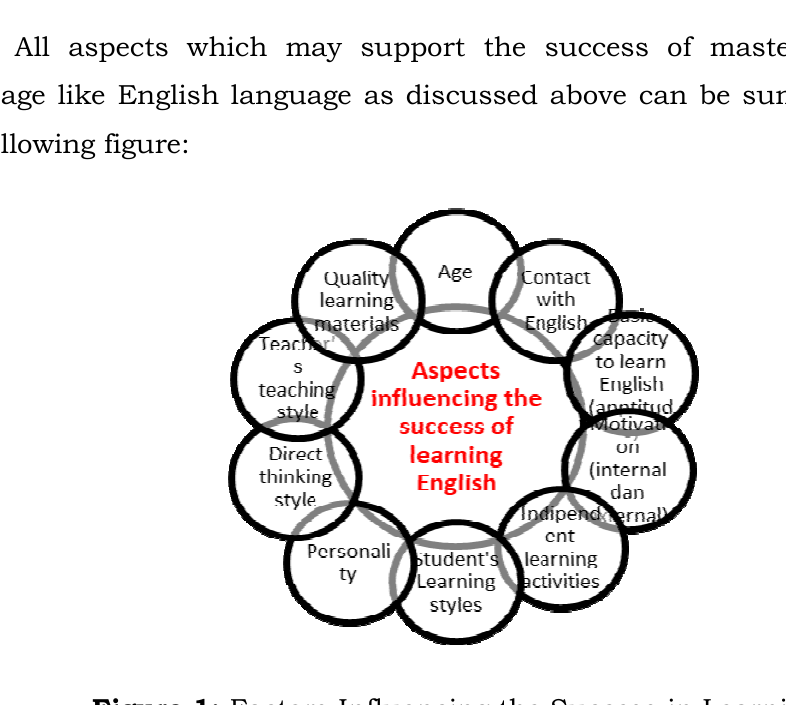
Figure 1: Factors Influencing the Success in Learning a Foreign